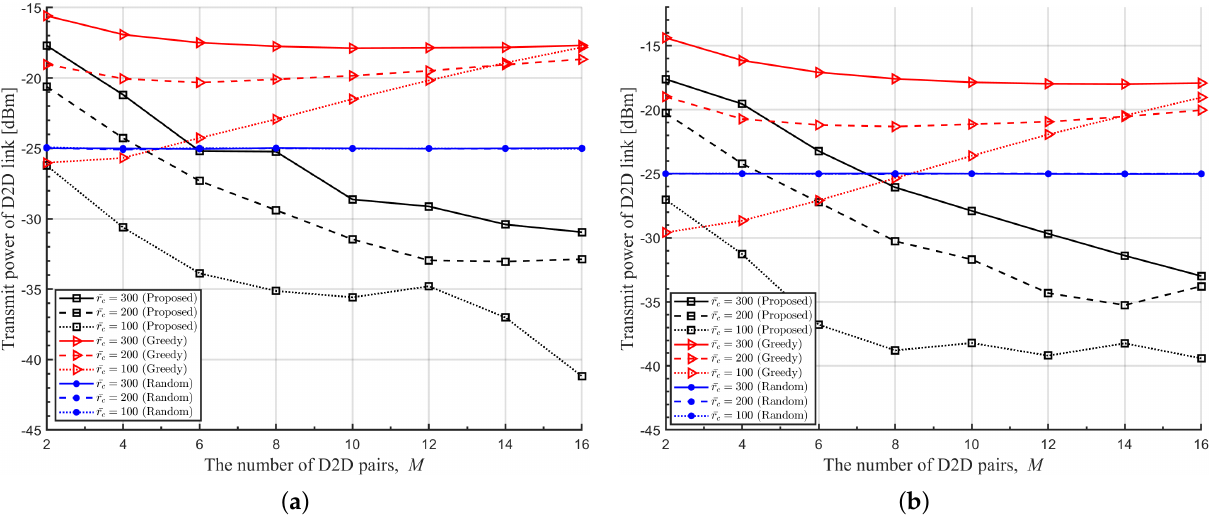
Figure 8. Average transmit power of DUET with respect to M for various ¯ r c . ( a ) R c = 6 [bits/s/Hz], ( b ) R c = 8